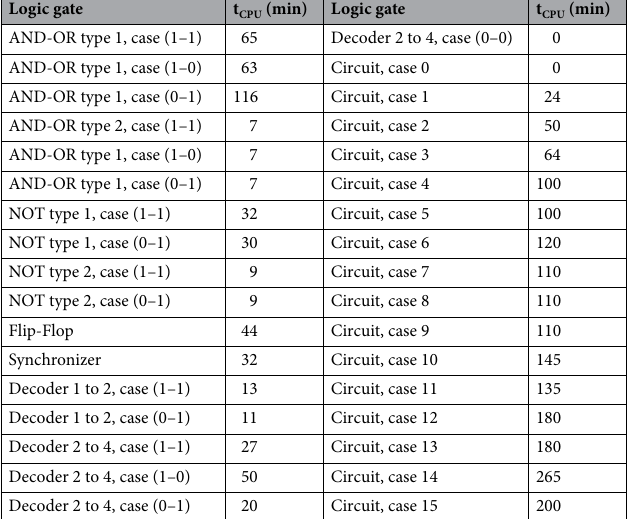
Table 4. The CPU time required for simulating the microfluidic-based logic gate models of water–air droplet microfluidic systems developed in this work.